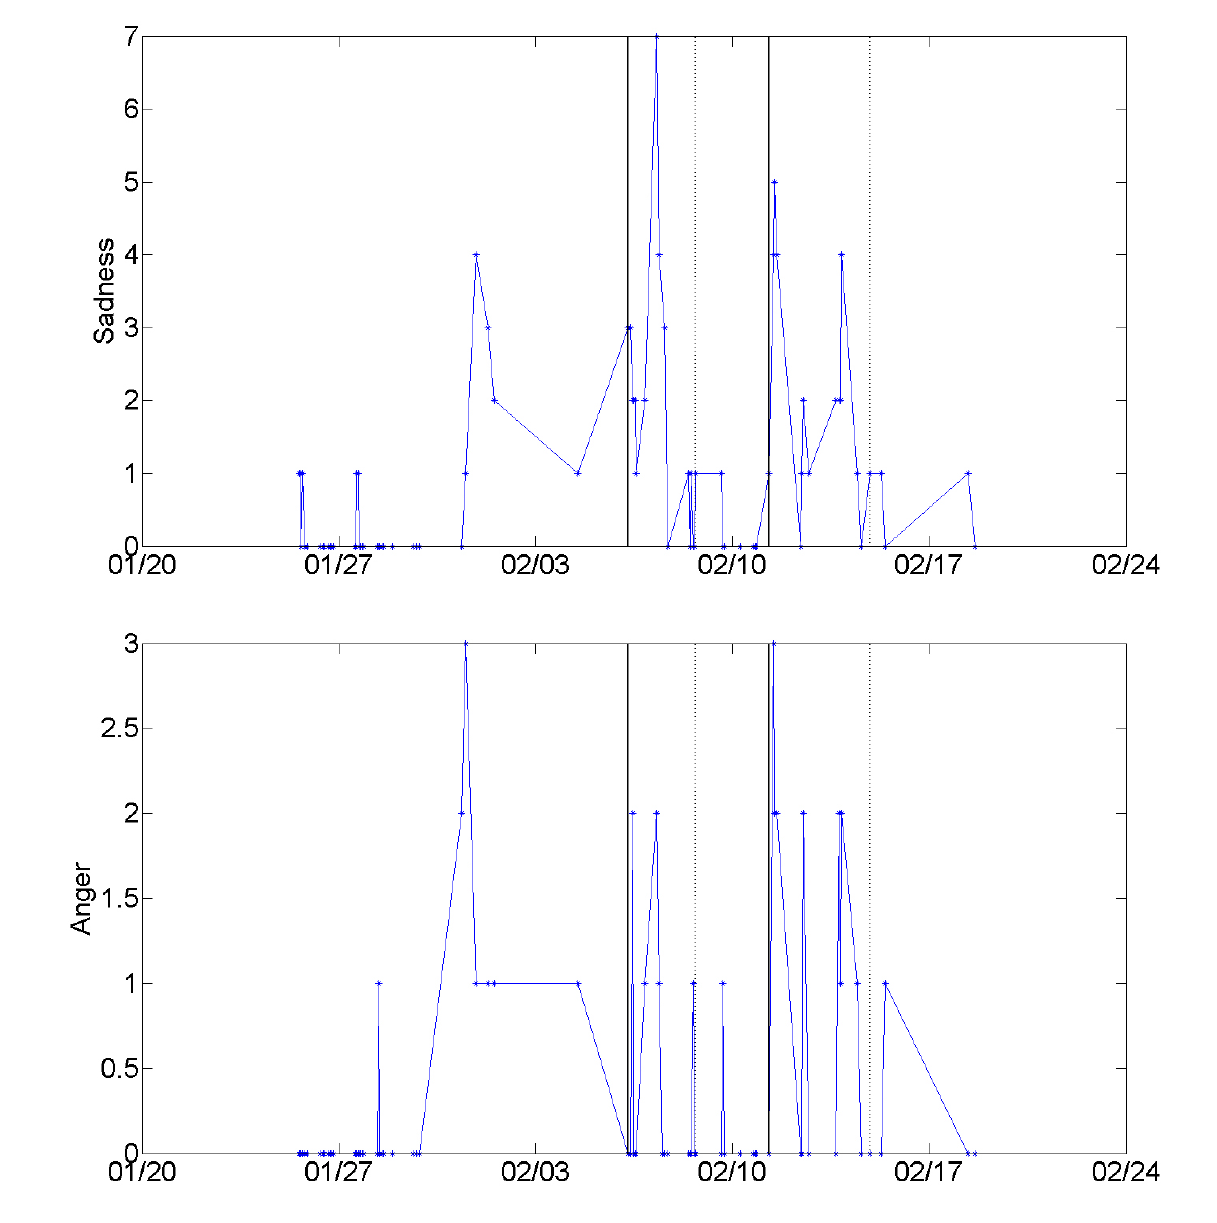
Figure 14. The time series of mood ratings echoes Eliza’s interview account of two stressful episodes; both were family conflicts that stretched over multiple days. The first episode (between 2/6 and 2/8) was characterized in mobile entries as sadness; the second (between 2/11 and 2/14) as sadness and anger. A solid vertical line marks the beginning of each episode, and the end of each episode is marked with a dotted vertical